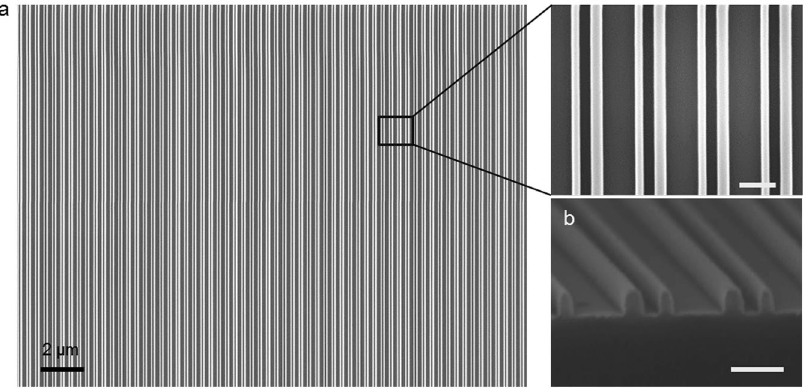
Figure 3. Scanning electron microscope images of the transmission mode metasurface. ( a ) SEM from the top view and with zoom-in image. ( b ) SEM of the cross section of the structure. The scale bar for the images in the right column is 200